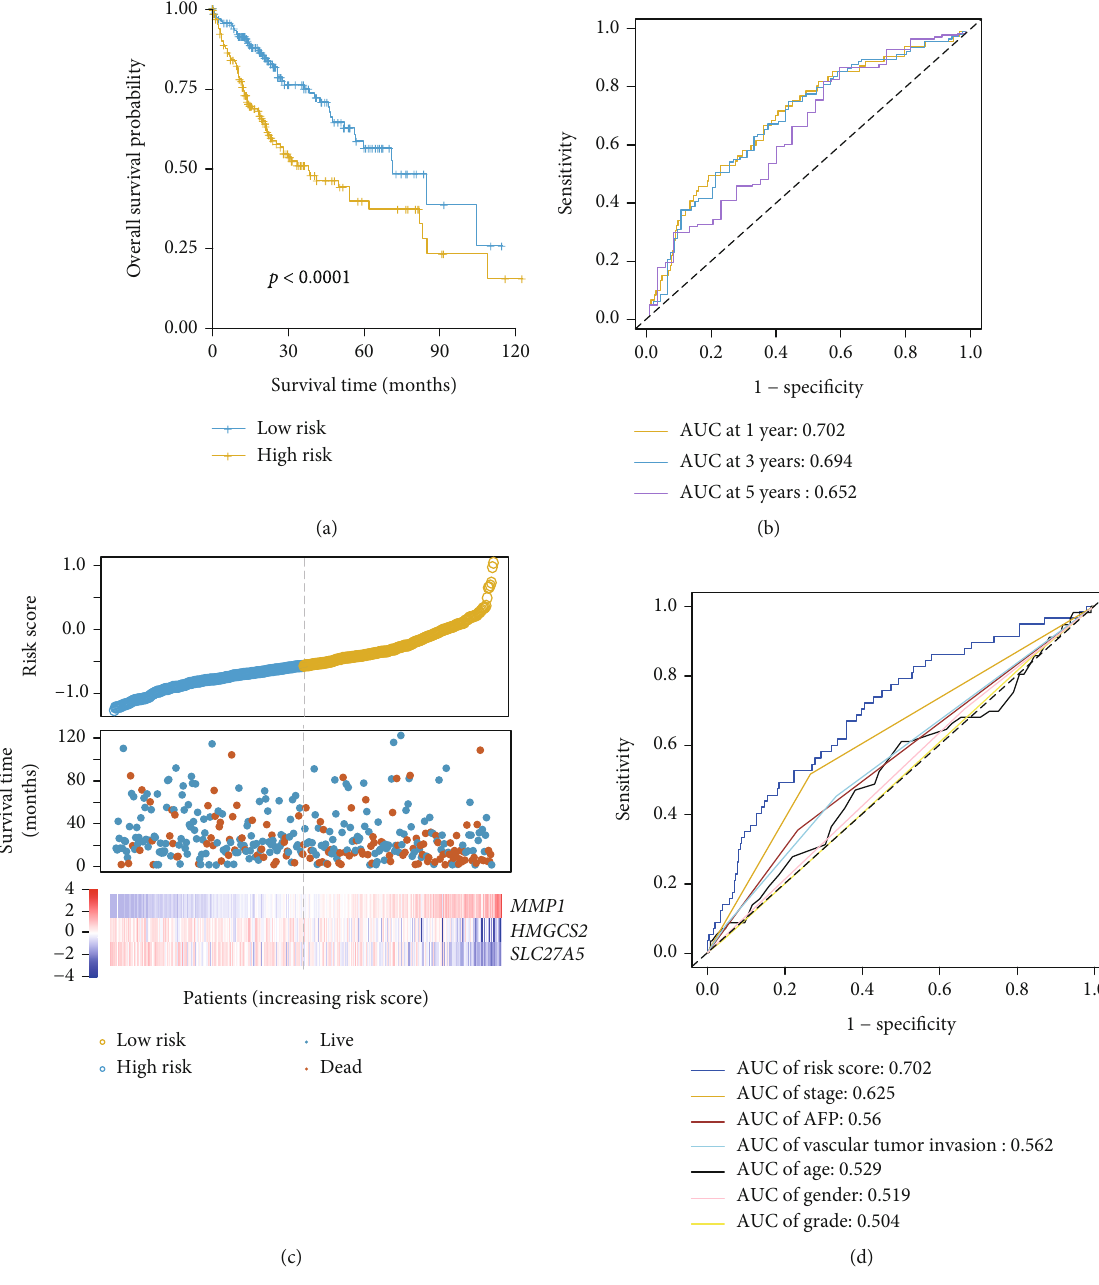
Figure 3: PPAR-associated prognostic genes were signi fi cantly associated with HCC patient overall survival. A Kaplan-Meier analysis of low- and high-risk patients in the TCGA HCC patient cohort, revealing a poorer prognosis for those with high-risk scores (a). A ROC analysis of risk scores was performed to assess their sensitivity and speci fi city (b). The relationship between risk scores, mortality, and characteristic gene expression (c). Risk score AUC values and clinical indicators at the one-year OS are shown